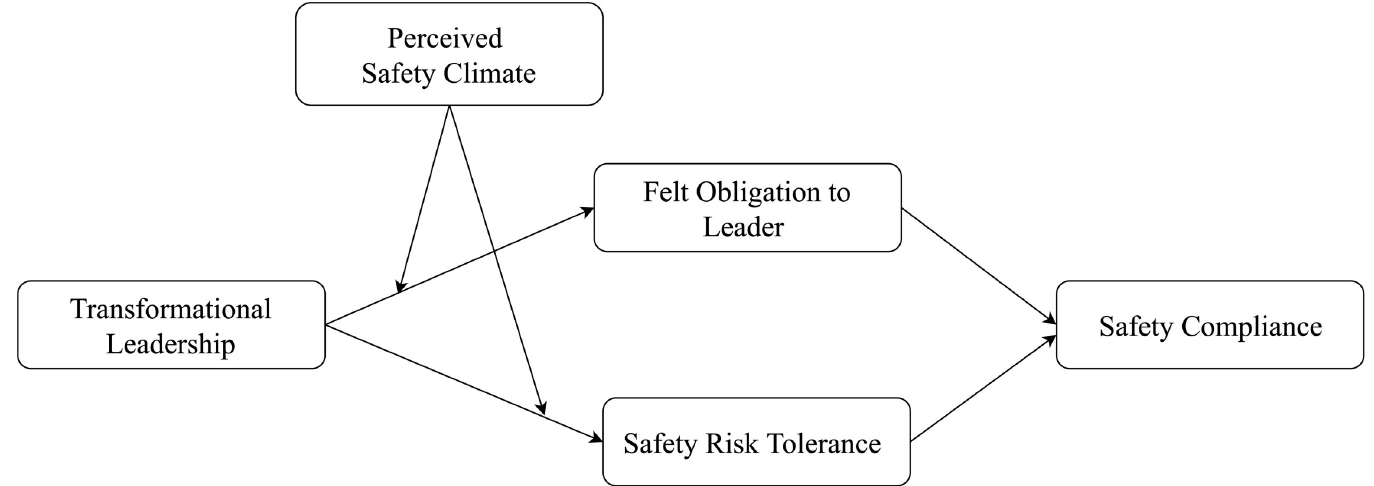
Fig 1. The dual-path model of transformational leadership on safety